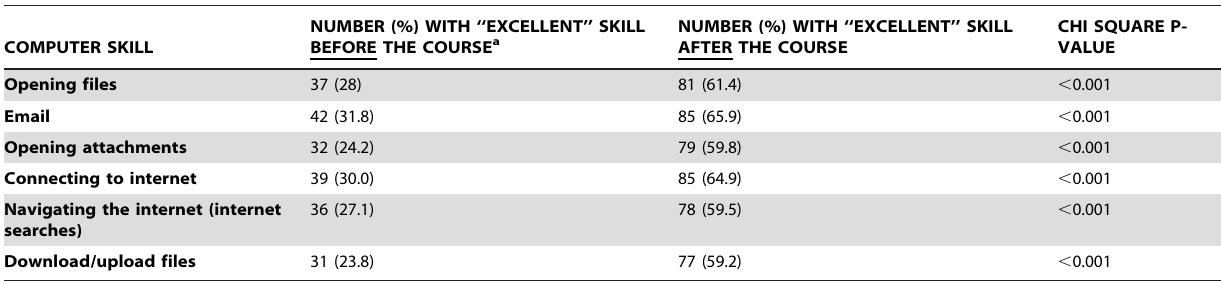
Table 2. Computer skills obtained.